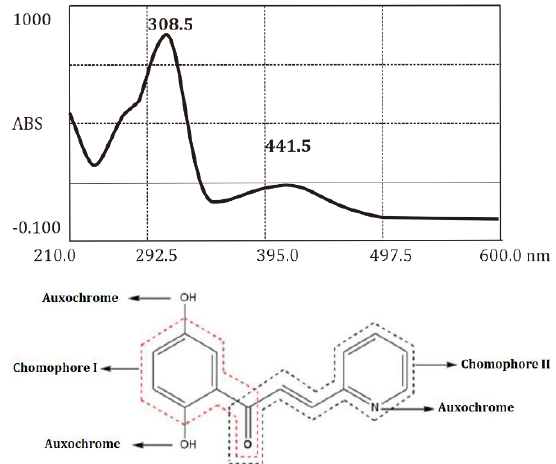
Figure 6. (A) The UV-Vis spectrum of the synthesis compound. (B) Chromophore system of AEW-1 1-(2,5-dihydroxyphenyl)-3-pyridine-2-il- propenone has aromatic rings (phenyl and pyridyl) connected with conjugated carbonyl α, β. The compound also has a hydroxyl (OH) group attached to the phenyl ring at the positions of 2 and 5. The IR spectrum of the synthesized compound (Figure 7) shows a wide absorption band of OH at wave number 3412cm -1